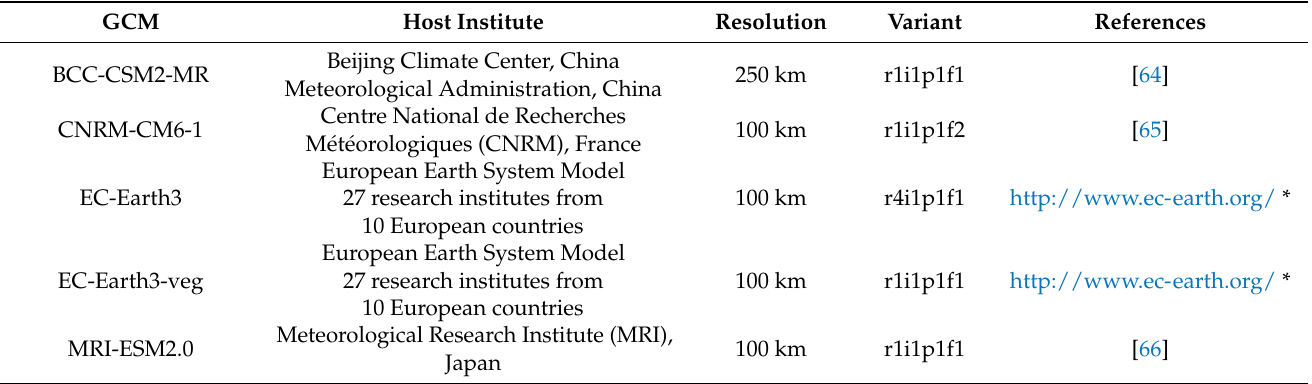
Table 1. Description of CMIP6 GCMs selected for the